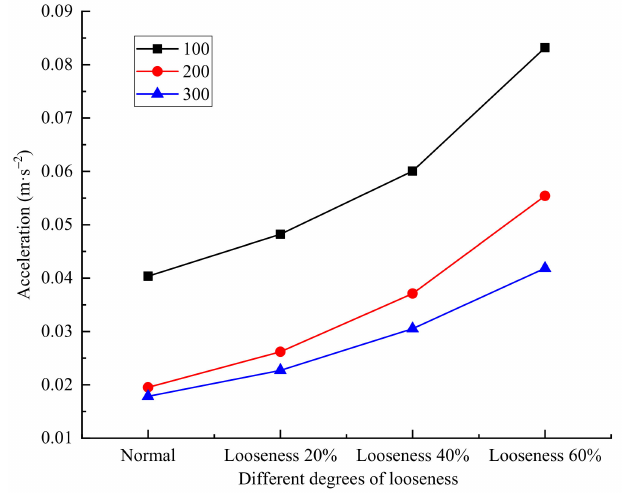
Figure 10. Amplitude change of loosening acceleration at 300 Hz in front of the winding.